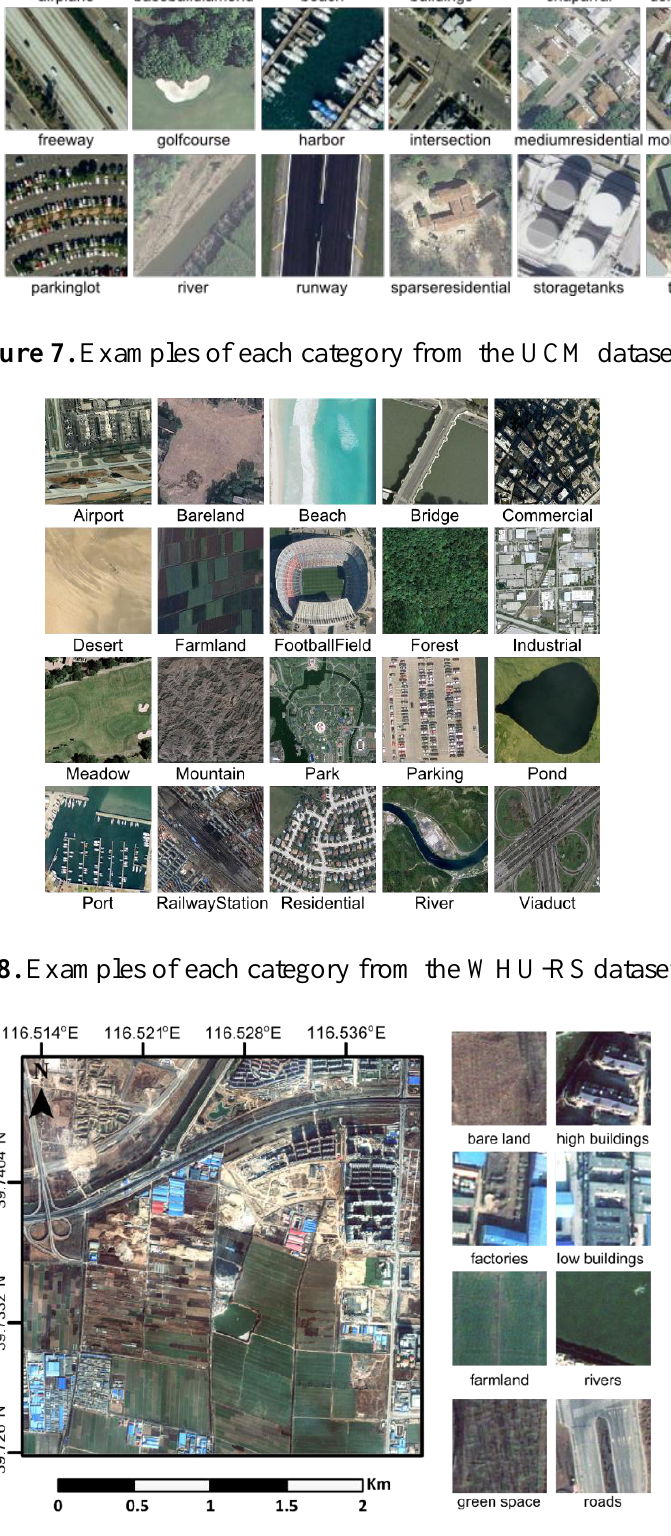
Figure 9. Original image of the Beijing dataset. The size of the raw GeoEye-1 image is 4000 × 4000 pixels. Examples from each category are shown on the